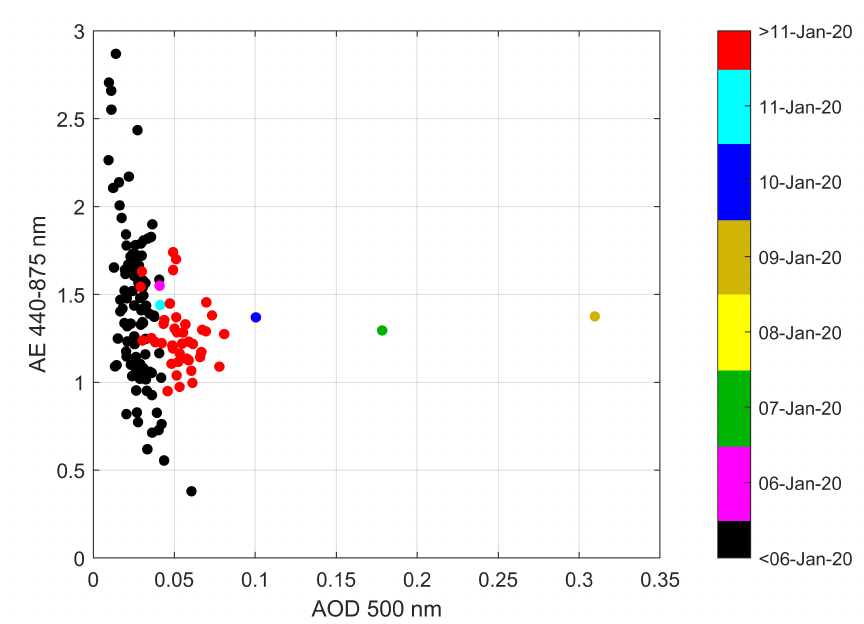
Figure 6. Daily mean of Ångström exponent (AE) vs. aerosol optical depth (AOD) at 500 nm at Marambio (until April 2020). Colorbar indicates the date of each data point highlighting the analyzed days of the event.